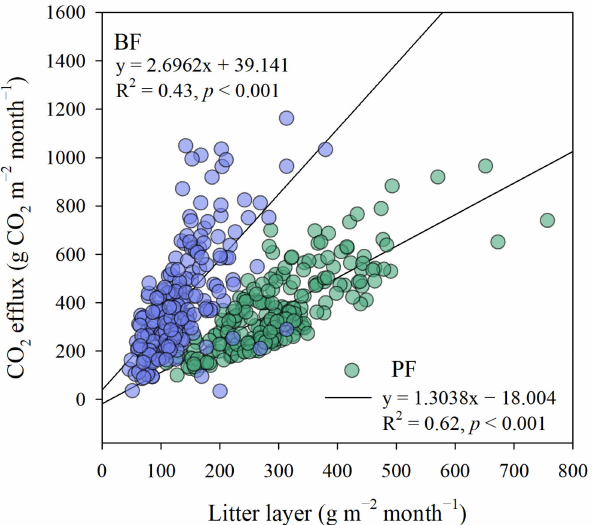
Figure 4. Correlations between monthly mean amount of surface litter and CO 2 efflux in PF (Masson pine forest) and BF (evergreen broadleaved forest) ( n =